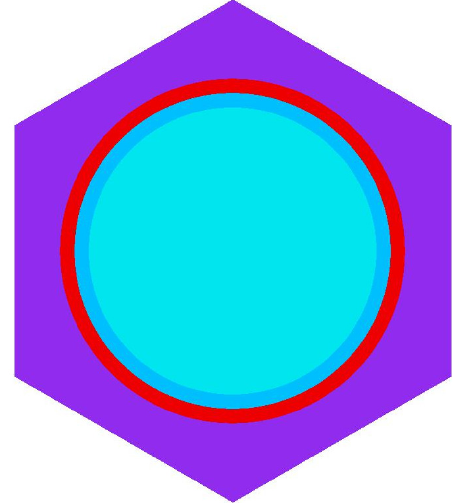
Figure 2. SCALE 6.2 model of radial RBWR-analogue pin-cell.